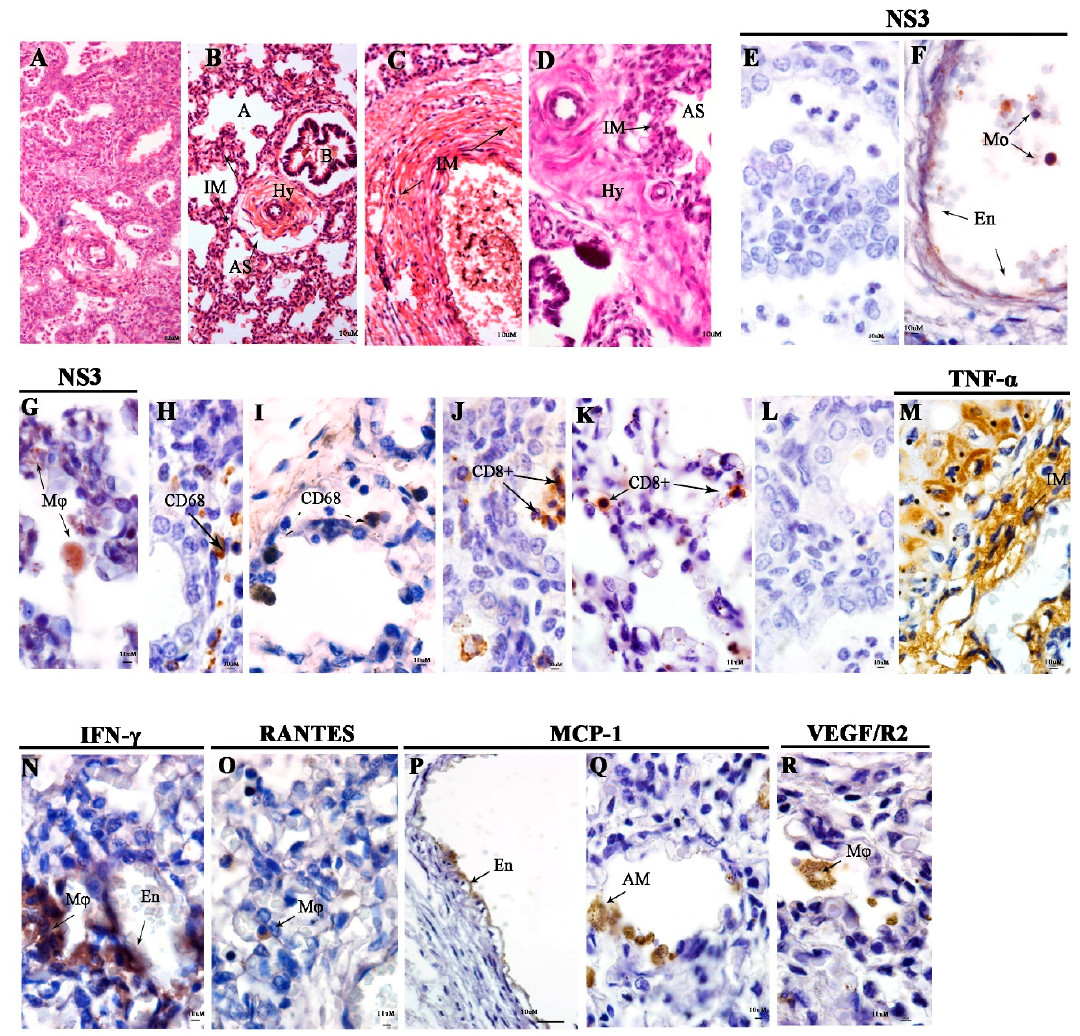
Figure 4. Histopathological and immunohistochemistry analysis of the lung. ( A ) Lung of a non-dengue case. In the stillborn lung, we observed the ( B ) presence of mononuclear infiltrates (IM) around the bronchus and hyalinosis (Hy). ( C ) Mononuclear infiltrates (IM) in the muscular tunica and ( D ) focal area of alveolar hyalinosis (Hy) with mononuclear infiltrate (IM). ( E ) Negative control without DENV NS3 staining. ( F ) Detection of DENV NS3 in monocytes (Mo) and endothelial cells (En) in vessels and ( G ) macrophage (Mø), in the alveolar space. ( H , I ) Presence of CD68 and ( J , K ) CD8 + T cells in the alveolar space. ( L ) Representative negative control of cytokine and inflammatory mediators from a non-DENV case. ( M ) TNF- α in mononuclear infiltrate (IM) ( N ) IFN- γ in macrophages and endothelial cells (En), ( O ) RANTES in macrophages (Mø), ( P , Q ) MCP-1 in endothelial cells (En), alveolar macrophages (AM), and ( R ) VEGF/R2 in macrophages (Mø).